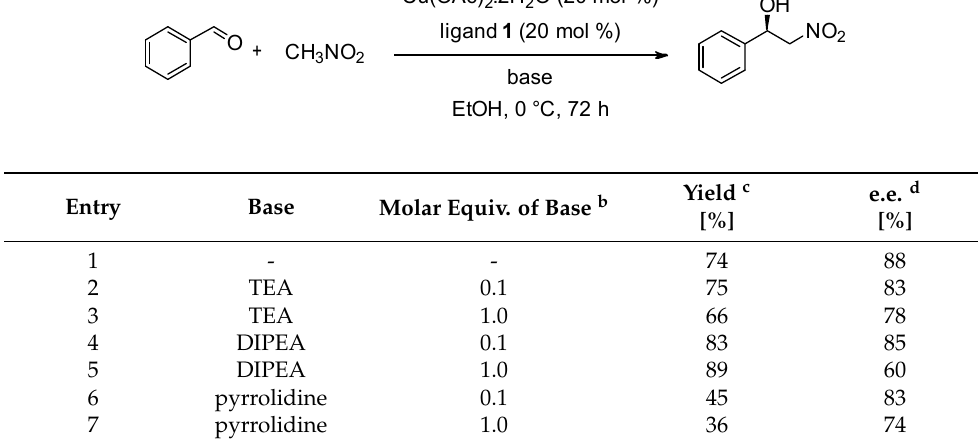
Table 4. Effect of the aldehyde structure on yield and enantioselectivity of the Henry reaction a . ligand 1 (20 mol %) CH 3 NO 2 hR CH O R EtOH, 0 °C, 48 Aldehyde Entry Aldehyde